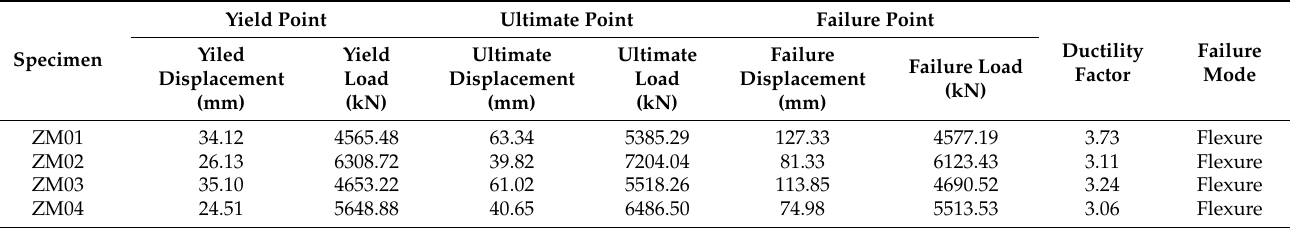
Table 6. FE results for specimens